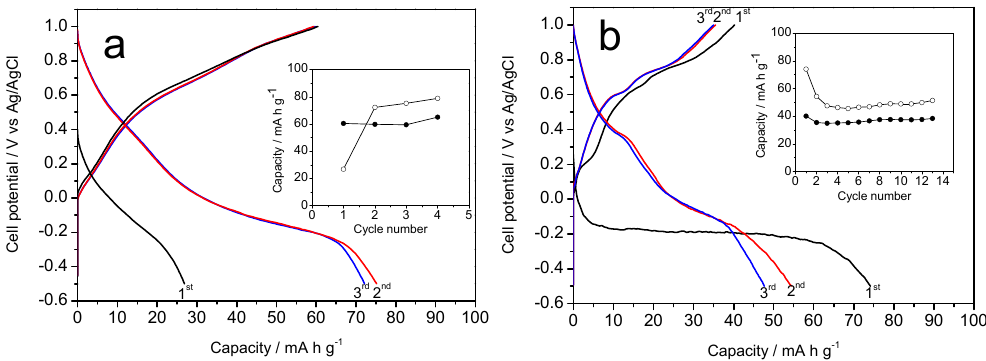
Figure 6. Galvanostatic curves in aqueous Na 2 SO 4 -based electrolyte recorded at C/10, referring the voltages to the Ag/AgCl electrode and starting with discharge: ( a ) K-B/SS and ( b ) K-B/HT. Insets: capacity vs. cycle number (open circles: discharge, filled circles: charge).